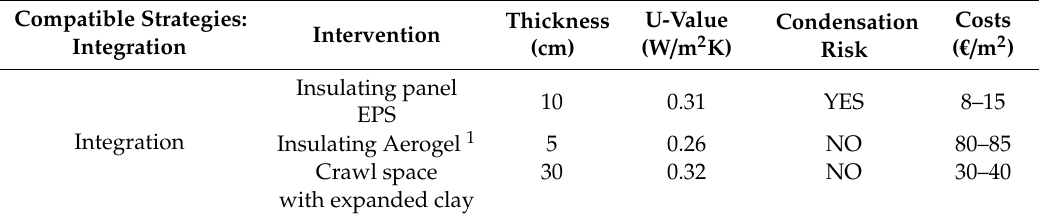
Table 5. Summary of the energy interventions studied for the ground